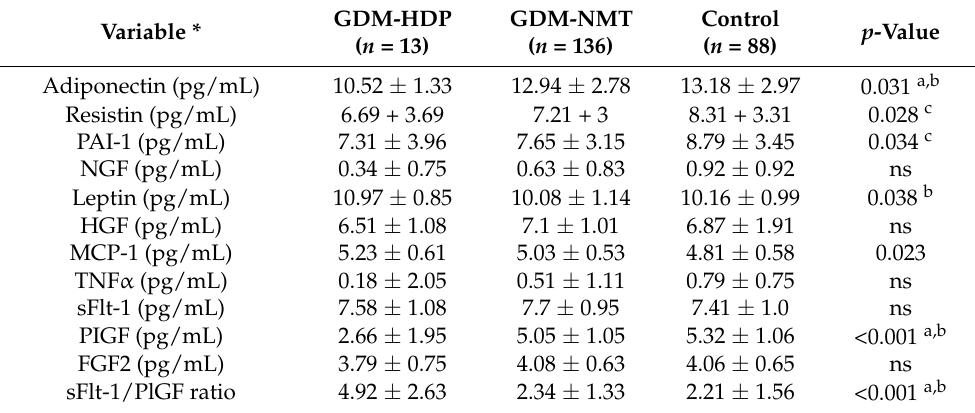
Table 3. Levels of soluble markers analyzed in women with HDP and without HDP.